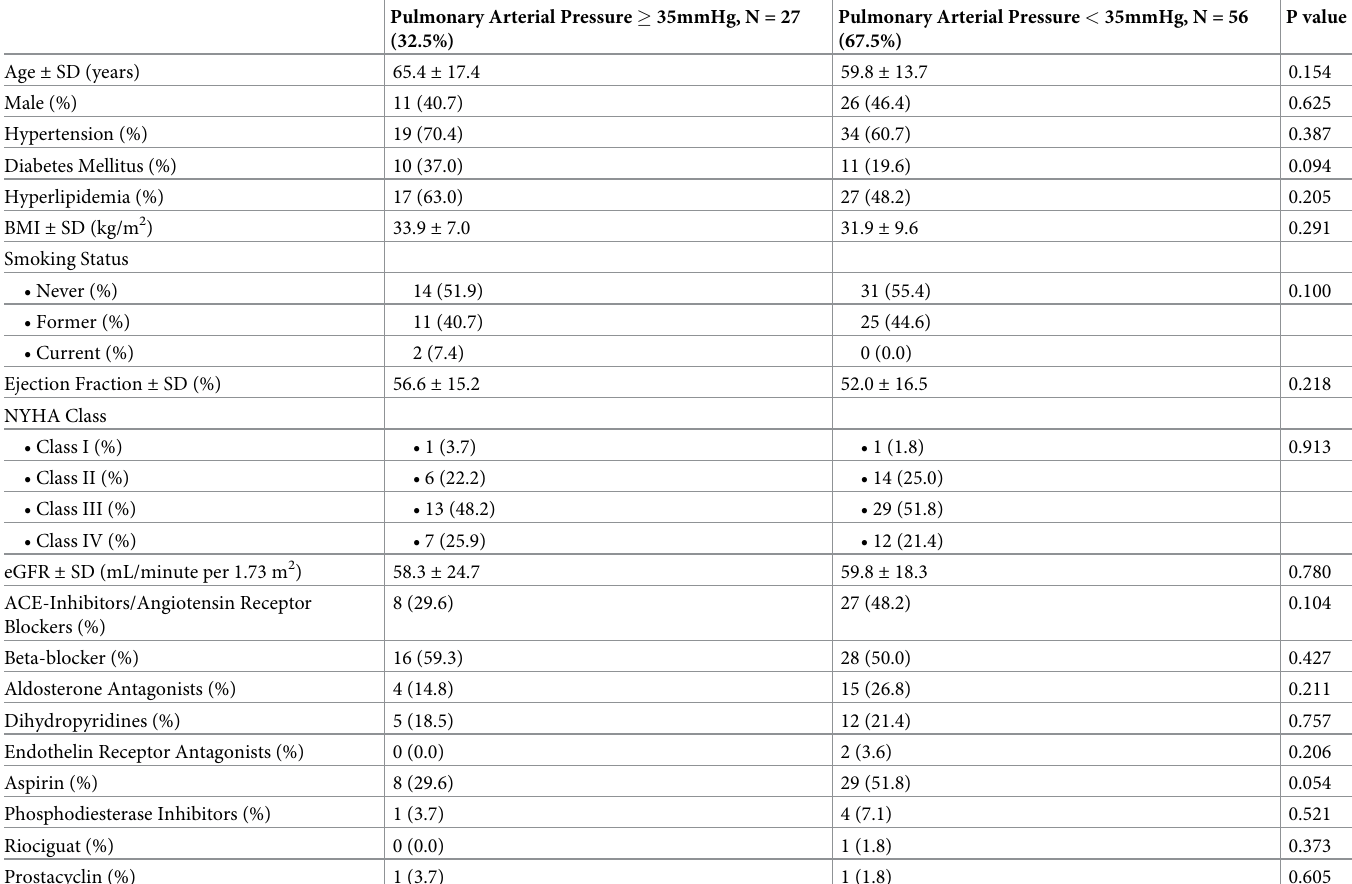
Table 1. Baseline characteristics of the study